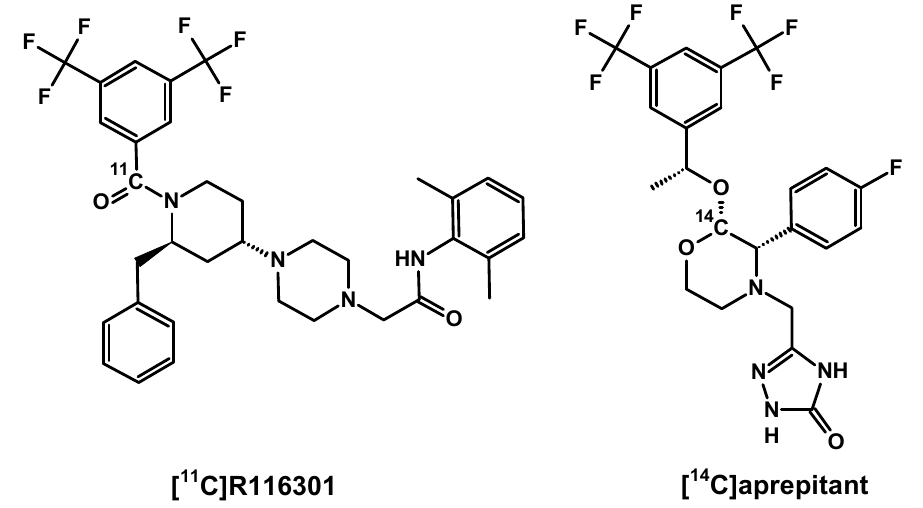
Figure 9. [ 11 C]R116301 (left) and exemplary [ 14 C]aprepitant (right) structures.